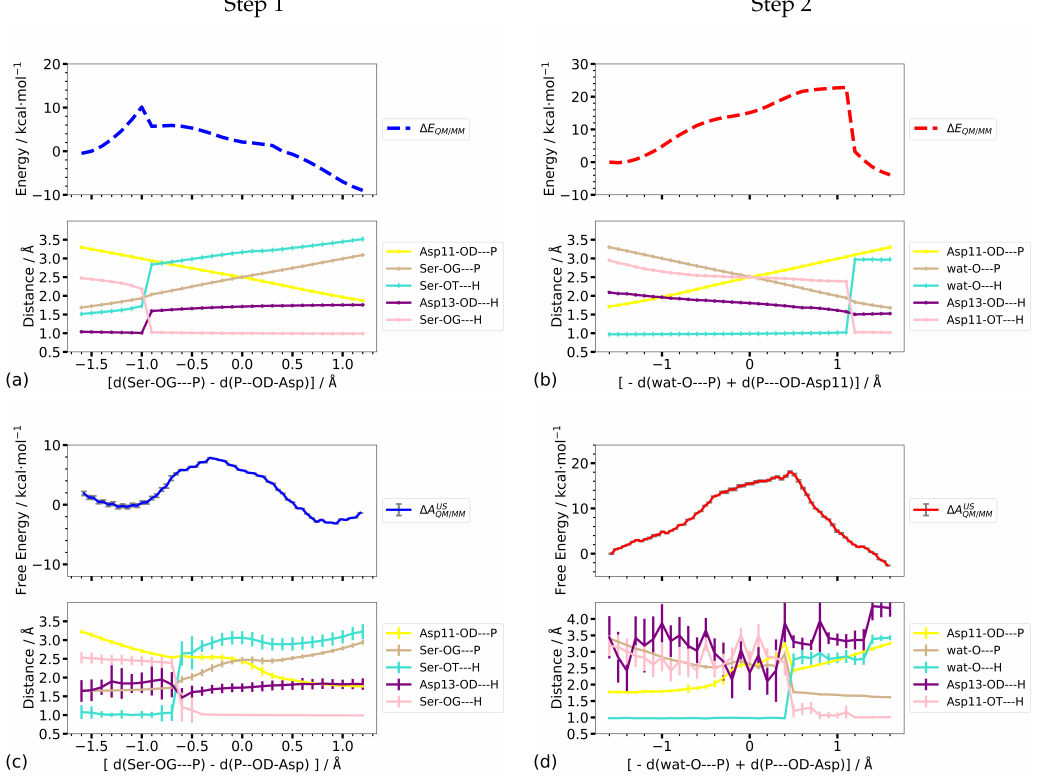
Figure 9. Reaction profiles from one-dimensional ( a , b ) potential energy scan and ( c , d ) umbrella sampling simulations, together with the evolution of important distances. The error bars for the distances from the umbrella sampling simulations represent the fluctuation of the distance in the respective